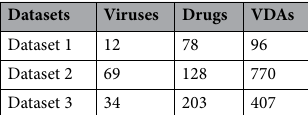
Table 9. Statistics for the virus-drug association